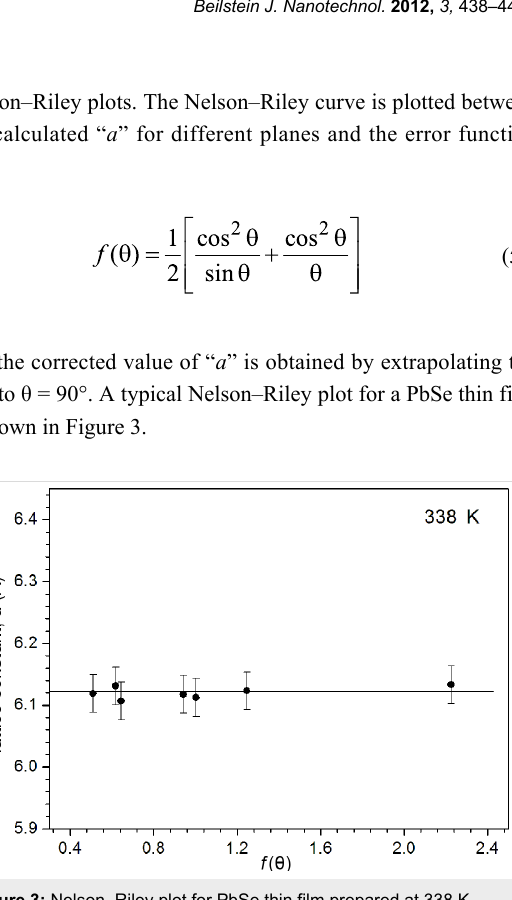
Figure 3: Nelson–Riley plot for PbSe thin film prepared at 338